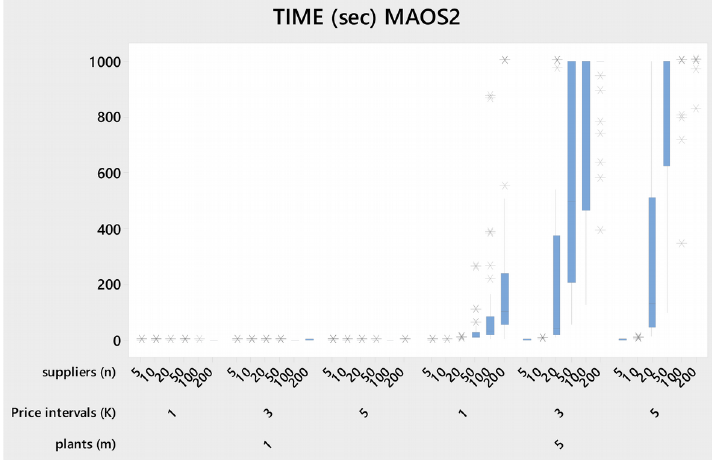
Figure 3. Solving time of MAOS2